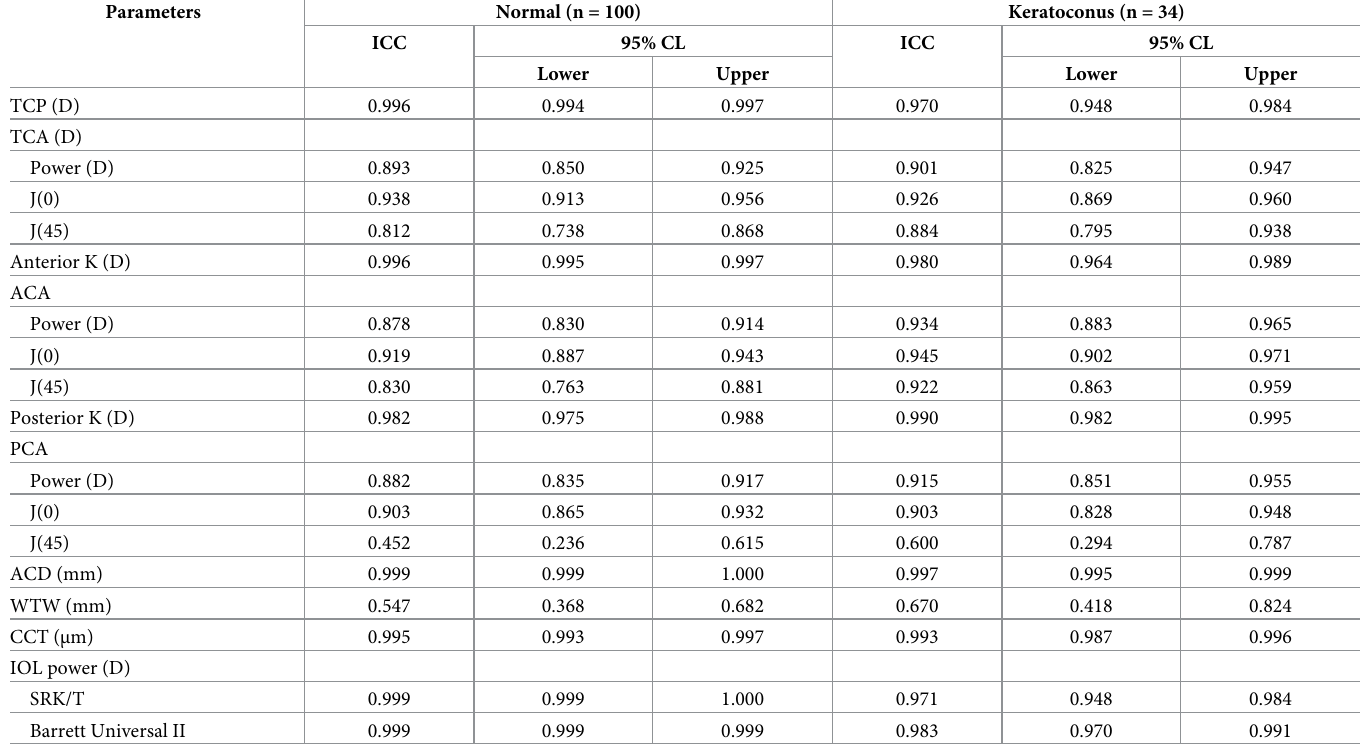
Table 5. Agreement among CASIA 2, Pentacam AXL, IOLMaster 700 in normal and keratoconus participants. Parameters